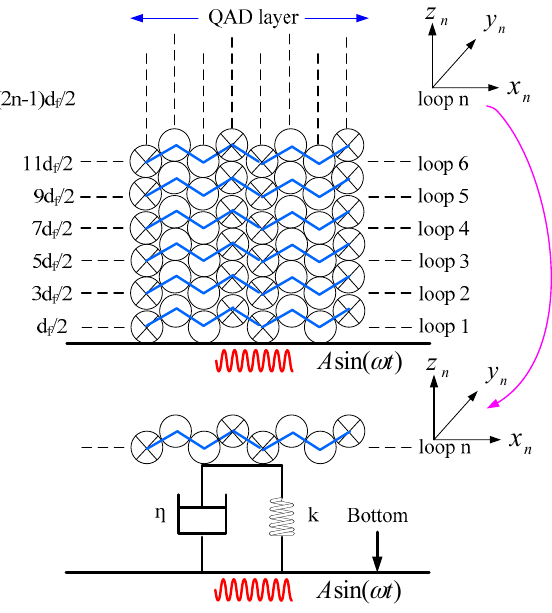
Figure 6. Dynamic model for each fiber loop under vibration.